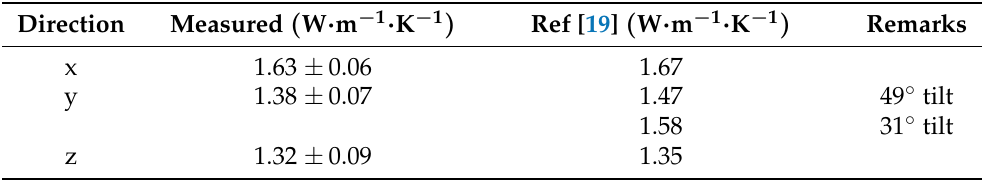
Table 1. Comparison of the measured specimen thermal conductivities to reference values of [19] by the laser flash